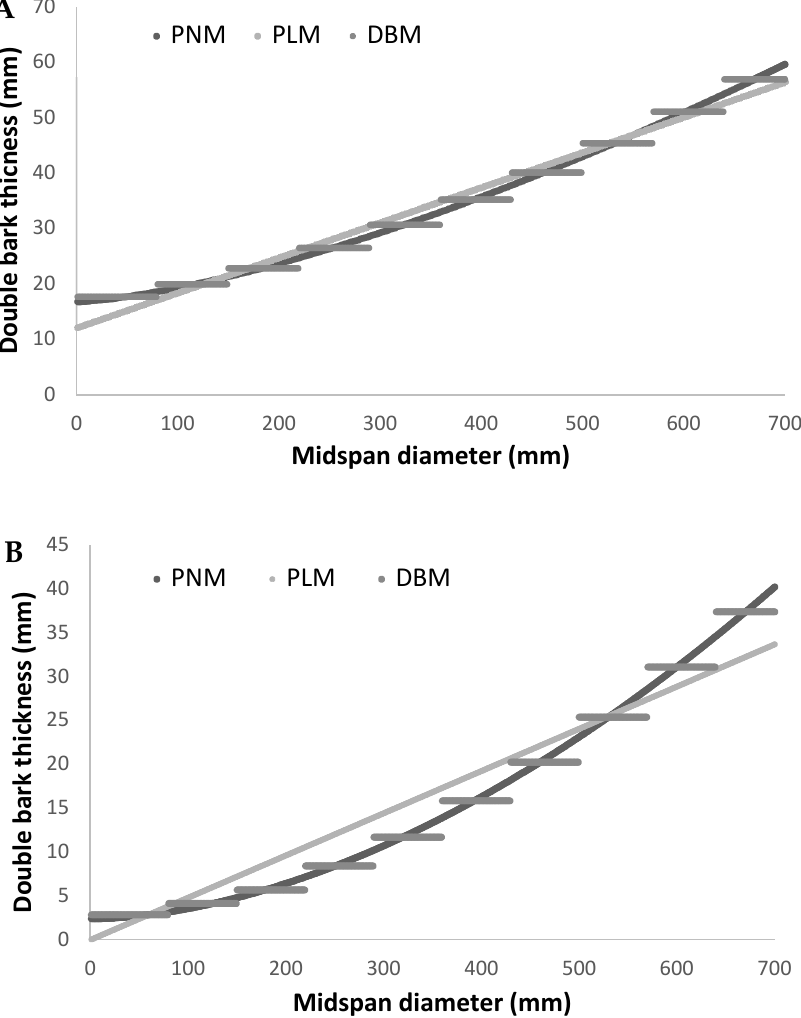
Figure 2. Comparison of double bark thickness curves using three various bark deduction methods (PNM, PLM, DBM) for Scots pine butt logs with rough bark ( A ) and for Scots pine logs with normal bark thickness ( B ).